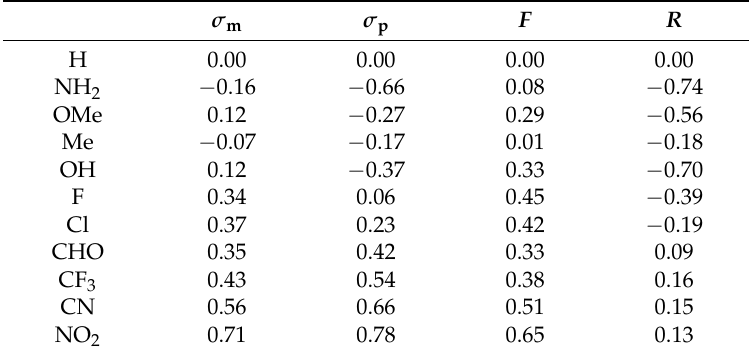
Table 1. The Hammett sigma constants ( σ m and σ p ) a , the field/inductive parameter ( F ) a and the resonance parameter ( R ) a of the